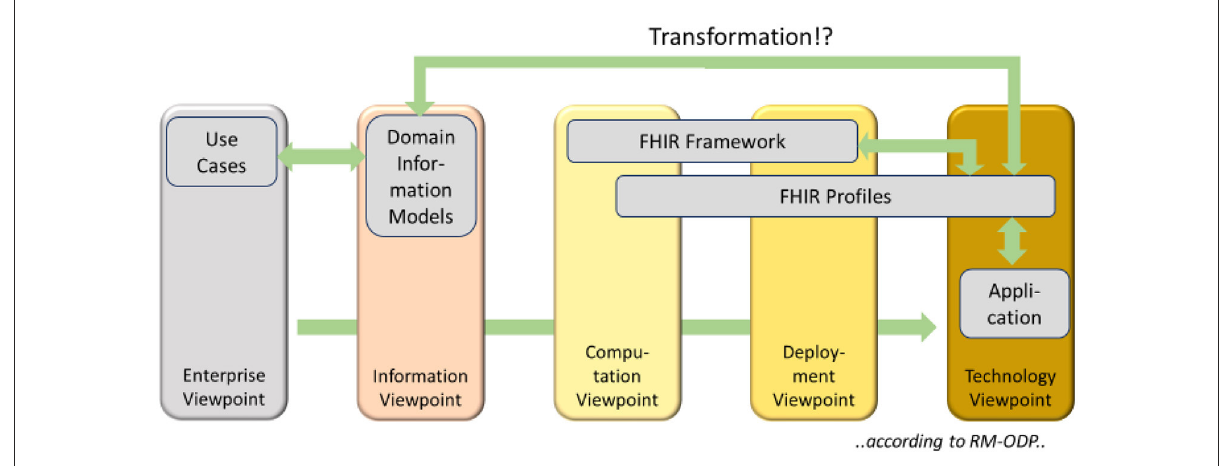
FIGURE1 FHIR Framework (3) according to RM-ODP